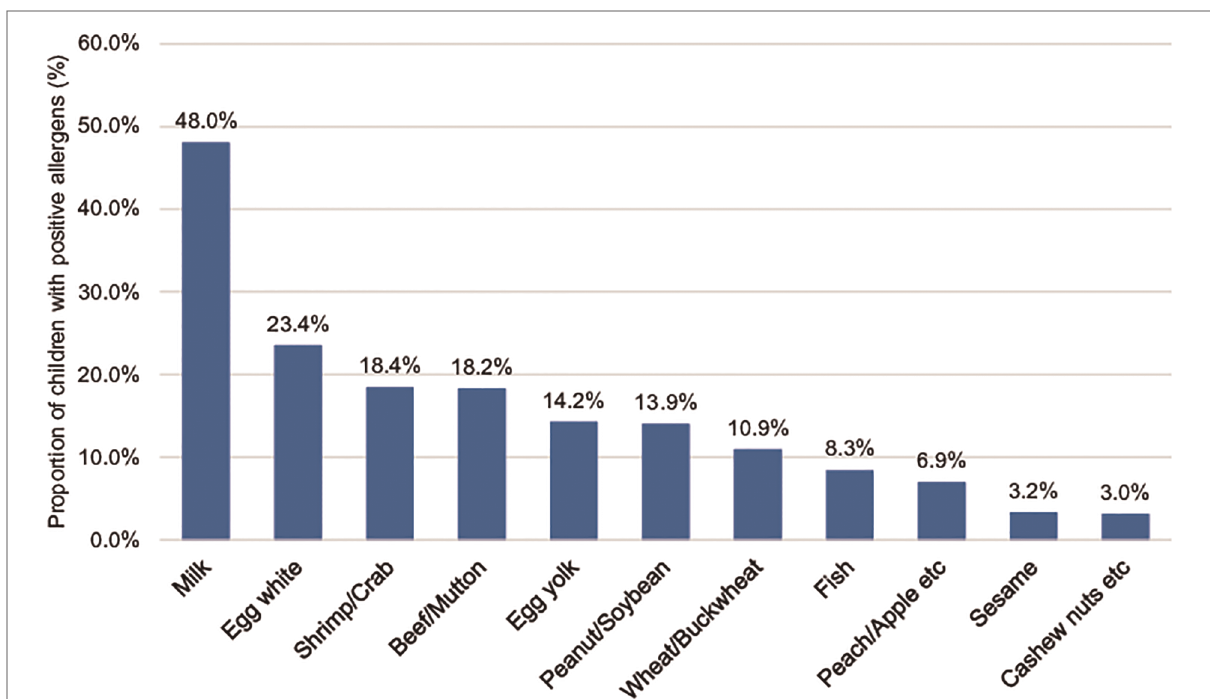
FIGURE 2 Distribution of ingestive allergens in 2,316 children with AR. The abscissa represents different ingestive allergens, and the ordinate exhibits their distributions in the AR